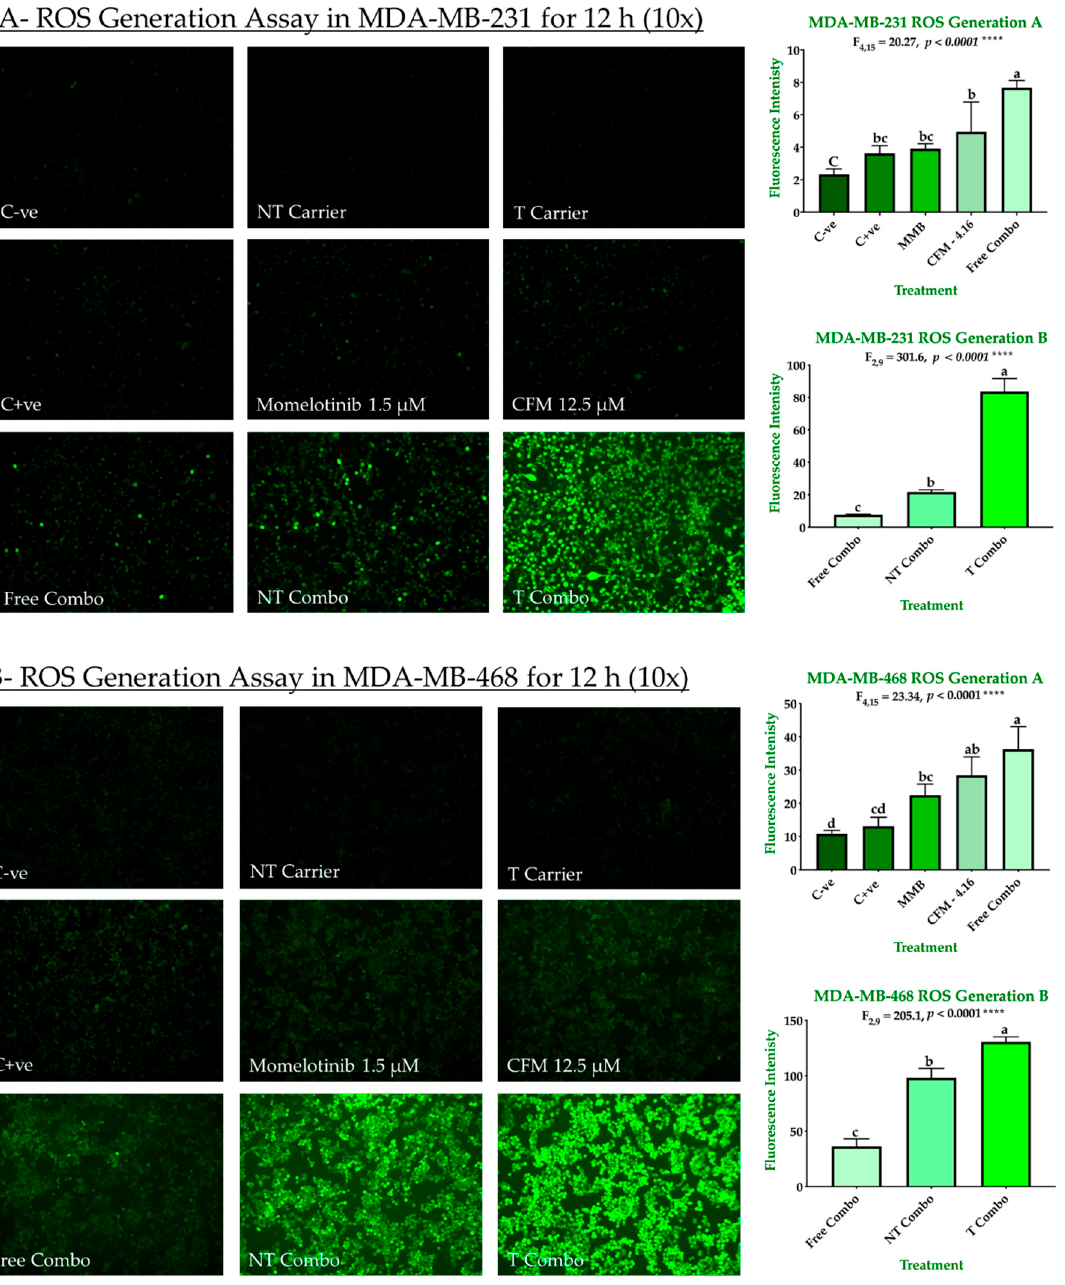
Figure 8. ROS generation in TNBC cell lines. The ability of MMB+CFM-4.16 combinations to promote antitumorigenic signaling and trigger oxidative stress-induced cancer apoptosis was evaluated in MDA-MB-231 ( A ) and MDA-MB-468 ( B ) by fluorescence H2DCFDA dye. The cells were treated for 12 h with MMB, CFM-4.16, free combo, NT-combo, T-combo, and equivalent doses of NT-carrier and T-carrier. H2O2 was used as a positive control. Then the media was removed, and the cells were stained for 30 min with non-fluorescent dye 2’,7’-dichlorodihydrofluorescein Diacetate (DCFH-DA) which is oxidized by the intracellular ROS to 2 ′ ,7 ′ -dichlorofluorescein (DCF). The wells were imaged by with (EVOS FL Auto,